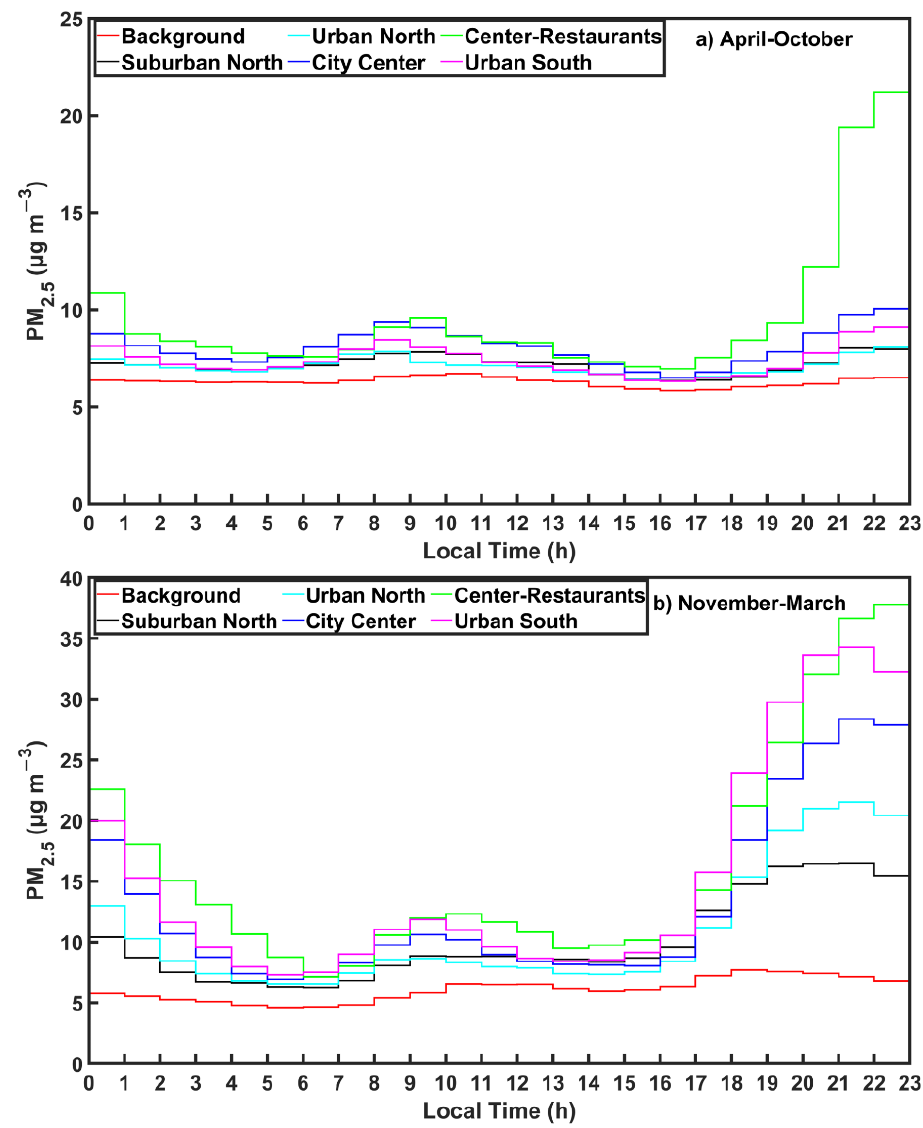
Figure 5. Average diurnal profile of PM 2 . 5 at the various examined areas during the ( a ) warm (April – October) and ( b ) colder (November – March) periods.